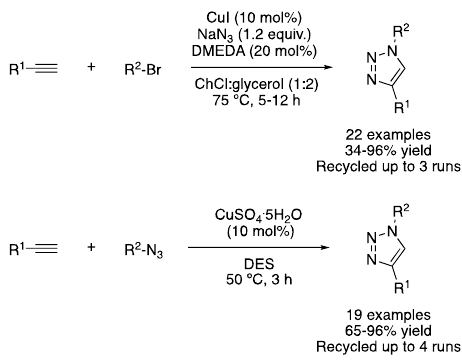
Figure 11. Syntheses of triazole